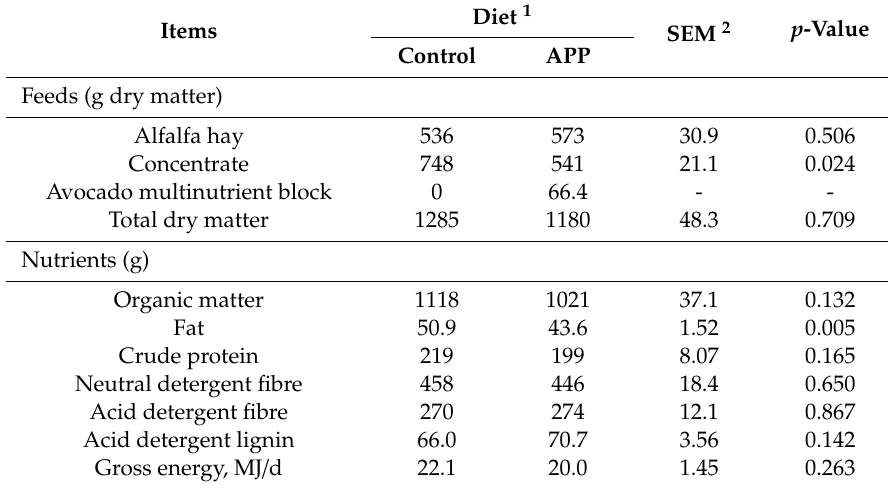
Table 3. Average values of individual daily intake of feeds and nutrients in dairy goats fed the experimental